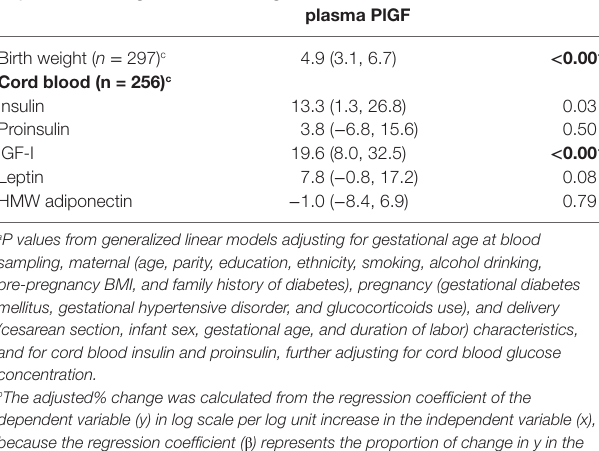
because the regression coefficient ( β ) represents the proportion of change in y in the original scale: log y 1 − log y 0 = β , then log (y 1 /y 0 ) = β , thus y 1 /y 0 = e β , and thus the